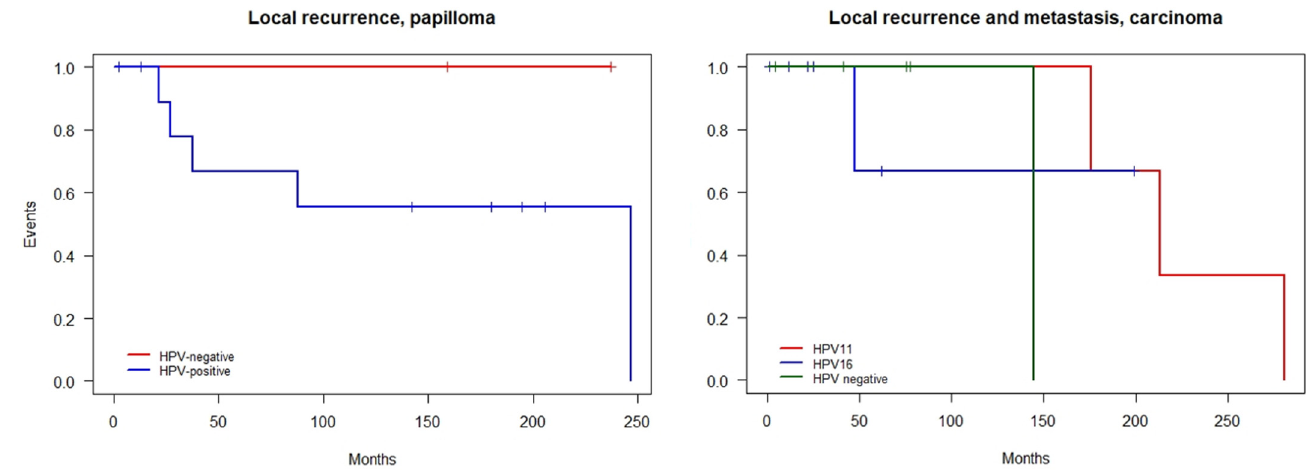
Figure 2. Kaplan–Meier plots illustrating the progression-free survival (PFS) in patients with squamous cell papilloma and carcinoma of the lacrimal drainage system based on human papillomavirus (HPV)-status.